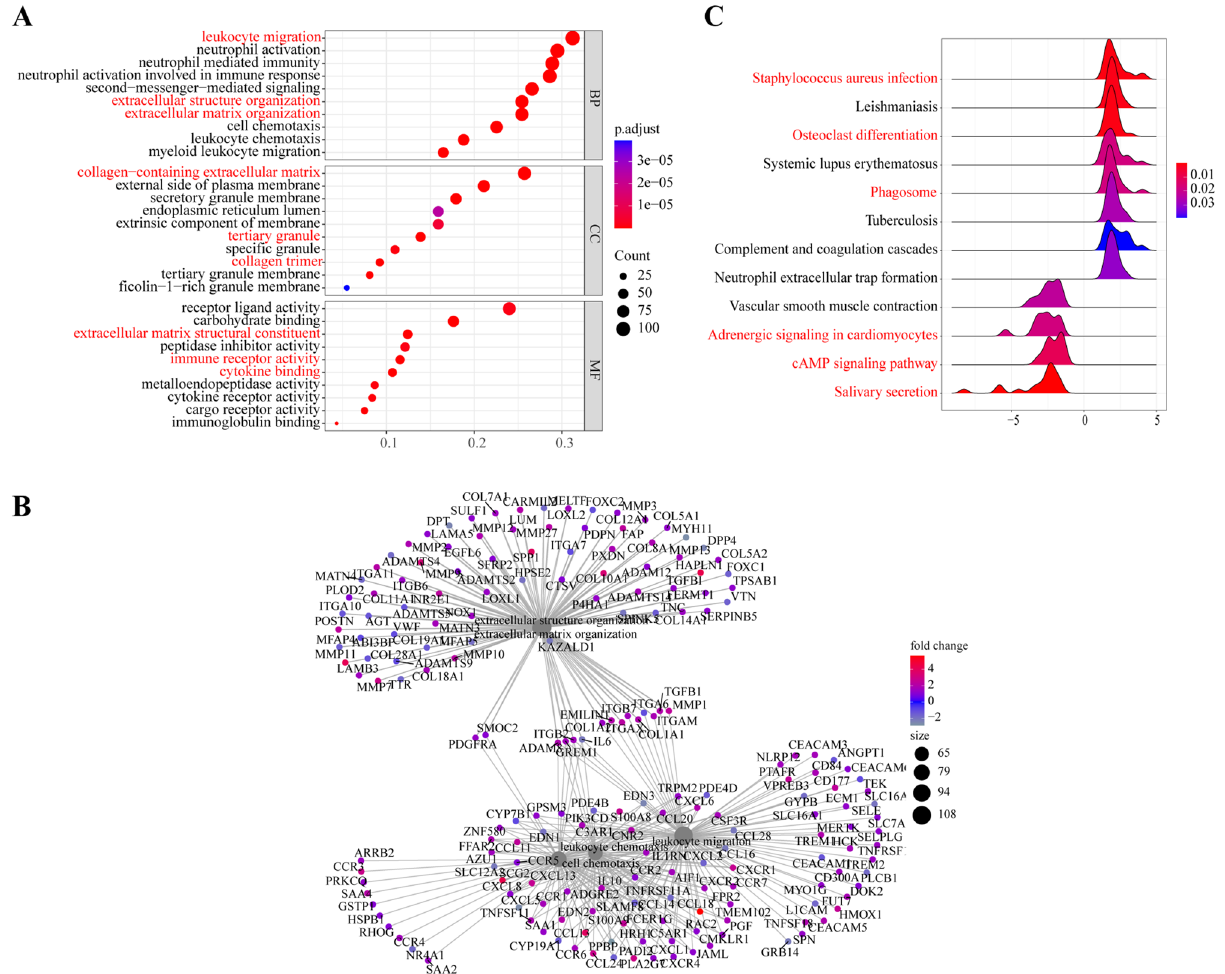
Figure 3. Functional enrichment analysis of DE-mRNAs. ( A ) GO analysis of DE-mRNAs in biological process (BP), molecular functions (MF) and cellular component (CC). ( B ) Gene symbols and interactions of the significantly DE-mRNAs in biological process (BP) are shown. ( C ) KEGG-GSEA pathway analysis of DE-mRNAs. GO, Gene Ontology; KEGG, Kyoto Encyclopedia of Genes and Genomes (www. kegg. jp/ kegg/ kegg1. html); GSEA, Gene Set Enrichment